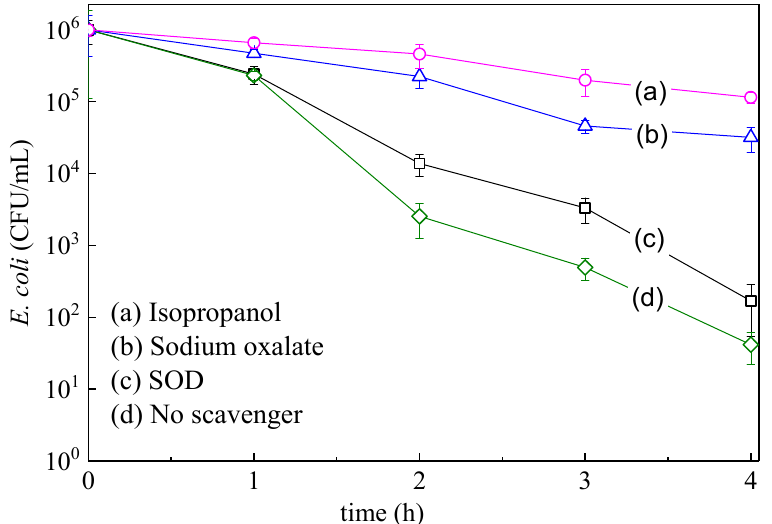
Figure 9. Effect of the scavengers during E. coli inactivation on Bi 2 WO 6 under solar simulated light for (a) isopropanol as OH-radical scavenger, (b) sodium oxalate a hole vb(h + ) scavenger, (c) superoxide dismutase (SOD) as an O 2.- scavenger, (d) no scavenger. Runs under low intensity solar simulated light (48 mW/cm 2 ). The solutions contained Bi 2 WO 6 (0.2 g/L) and scavenger concentration of 0.1 mM.